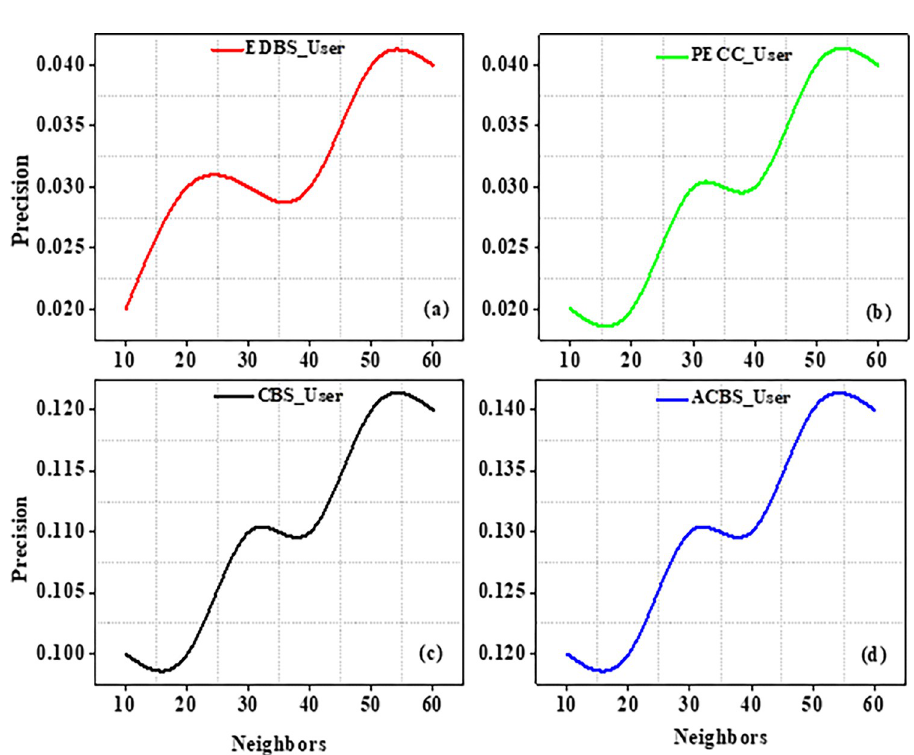
Fig 6. Precision with different neighbors.